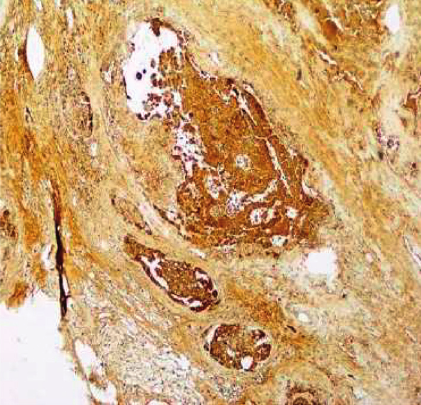
Figure 3: Human chorionic gonadotropin-positive immunohis- tochemical